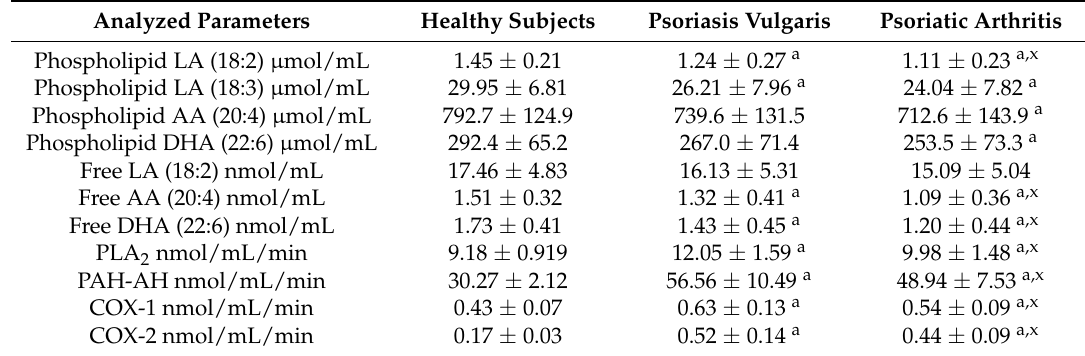
Table 2. The level of phospholipids, free fatty acids, and the activity of the enzymes that metabolize phospholipids and lipid mediators in plasma from healthy subjects (n = 34) as well as patients with psoriasis vulgaris (n = 68) and psoriatic arthritis (n = 34).